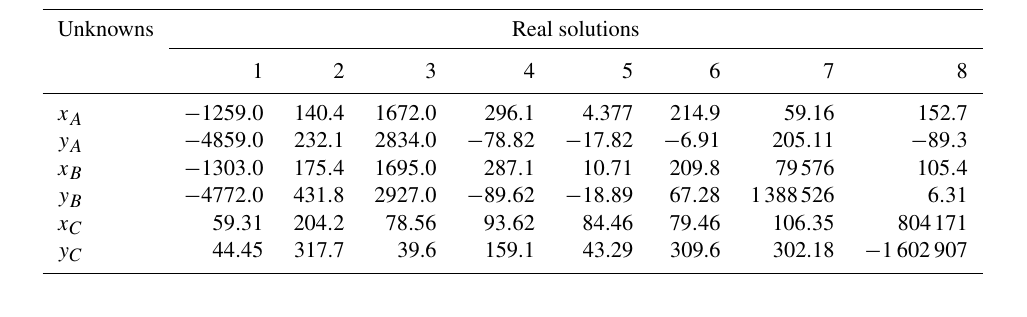
Mech. Sci., 13, 275–290,